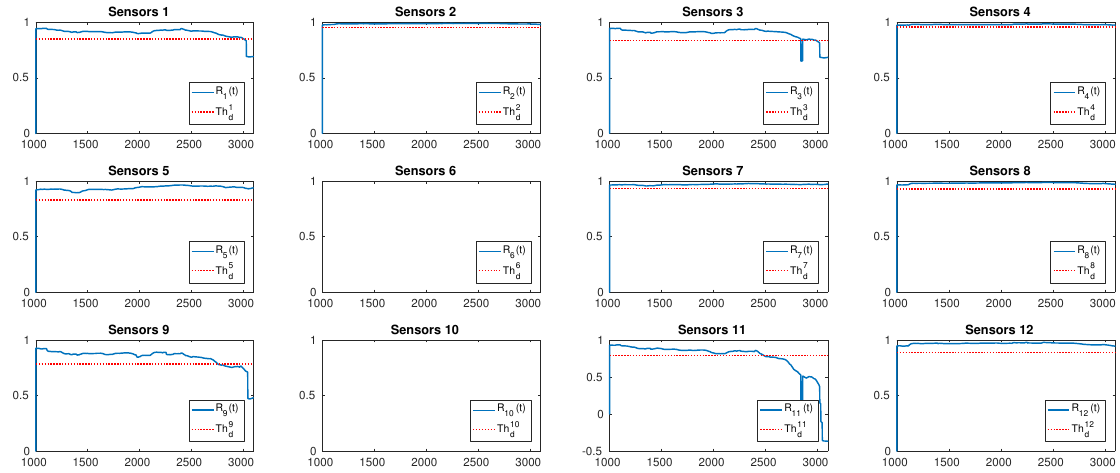
Figure 5. An example of change detection analysis carried out on cross-correlation indices R i ( t ) of all the sensors when the attacked sensor is u 11 . The first S = 1000 samples belong to the training sequence. In each sub-figure, on the x-axis, we have the samples and, on the y-axis, we have the cross-correlation corresponds to Θ i in the index. In the legends, the symbol Th i d d